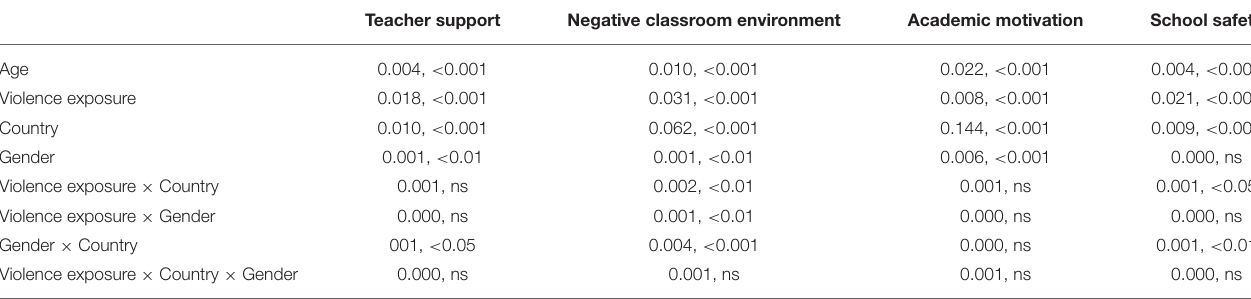
TABLE 3 | Effect sizes for each dependent variable and summary statistics ( η 2 ,